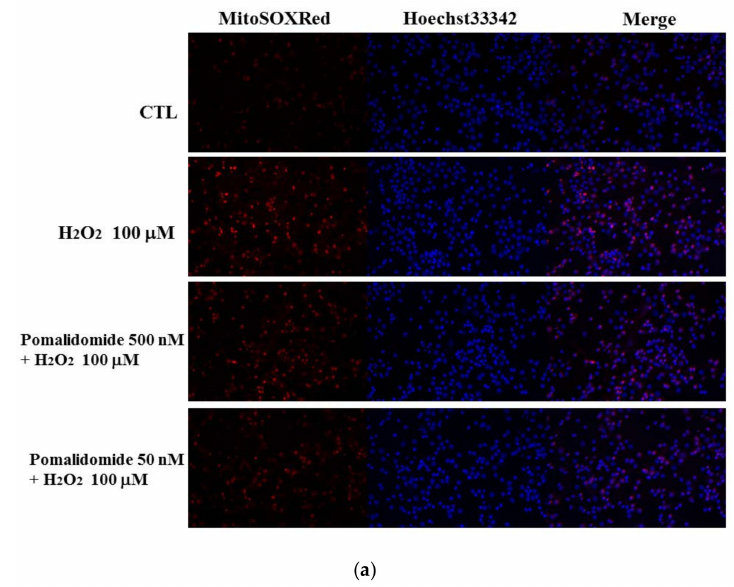
Cells were labeled with